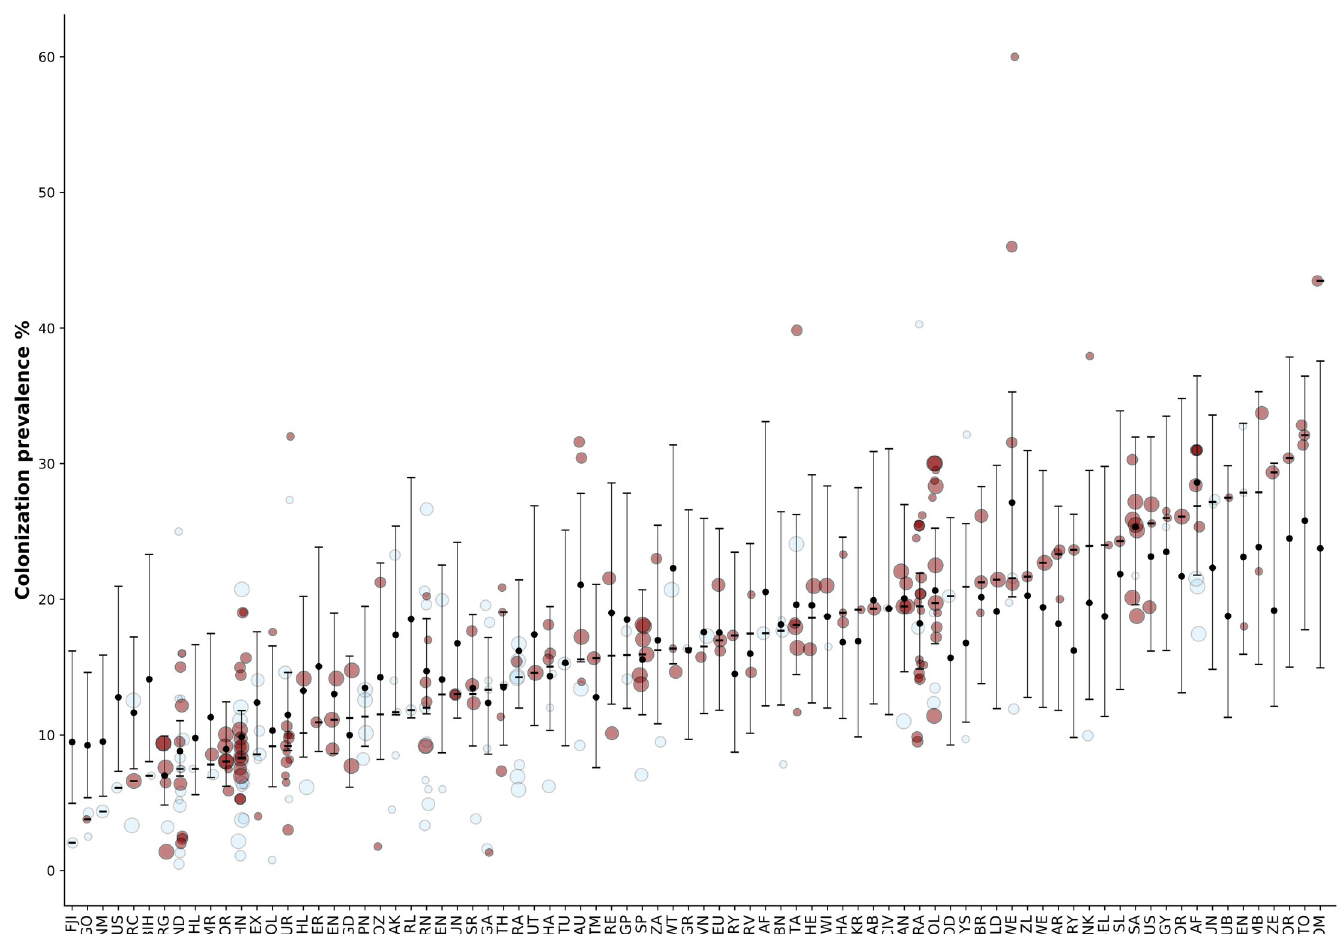
Fig 3. Estimated maternal GBS colonization prevalence (y-axis) in countries (x-axis) with epidemiological data. Red circles represent studies that used sensitive GBS detection protocols. Black circles represent posterior medians and lines, 95% intervals; these estimates correspond to country-level prevalences as quantified by sensitive methods, i.e. inverse logit function of μ , and not to estimated prevalences in new GBS colonization studies, which would need to incorporate between-study variation and j sampling variation.